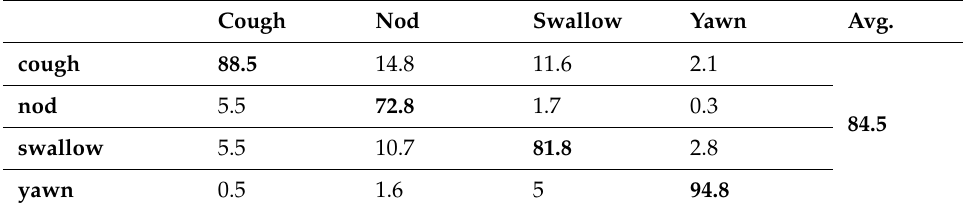
Table 2. Confusion matrices of noises predictions for NN (%).